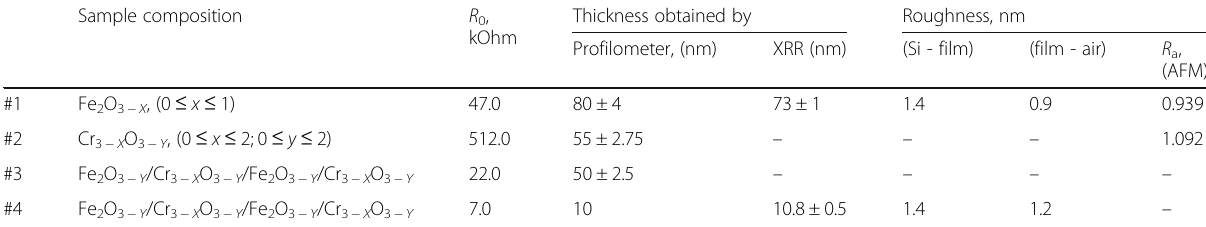
Table 1 Some parameters of typical samples investigated, T = 296 K Sample composition R 0 ,